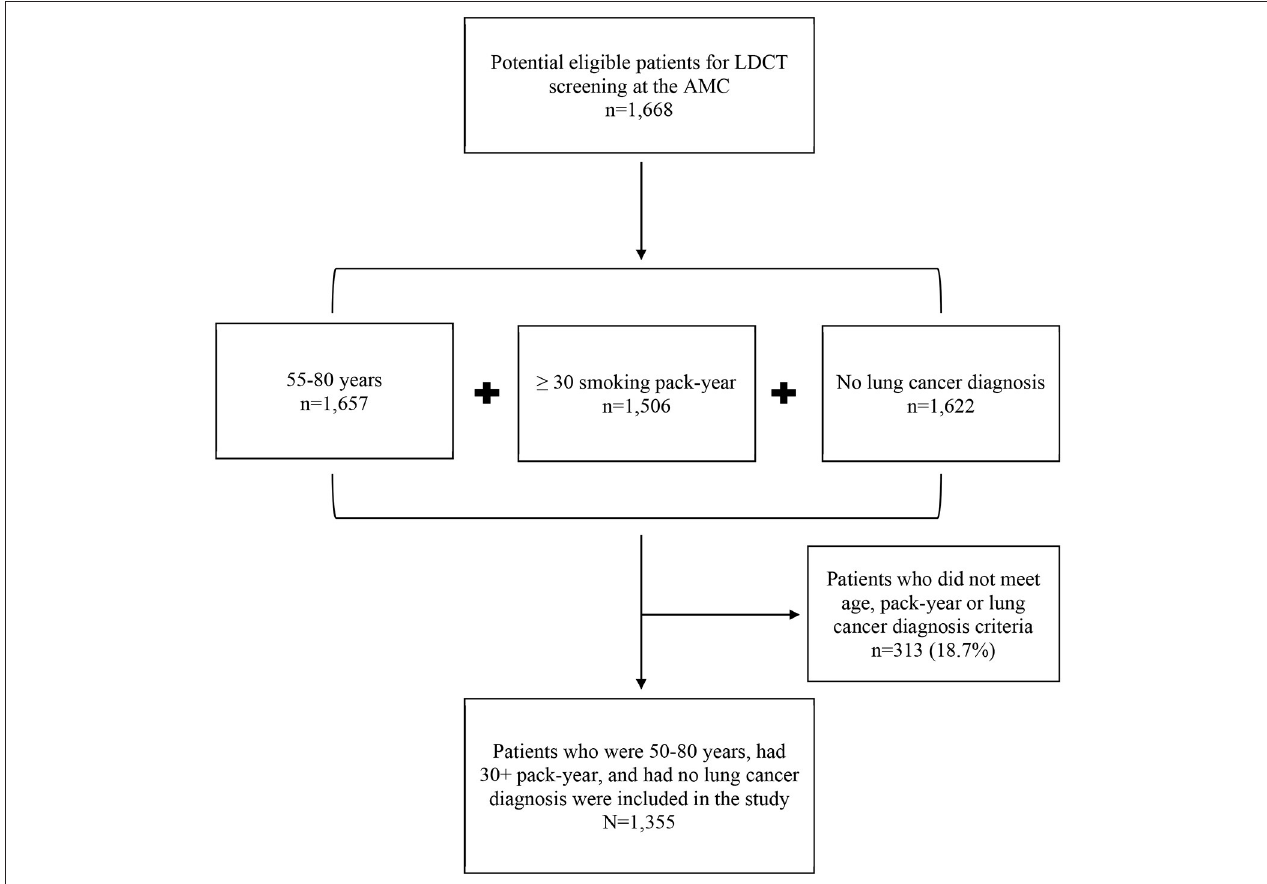
FIGURE 1 | Study sample flow